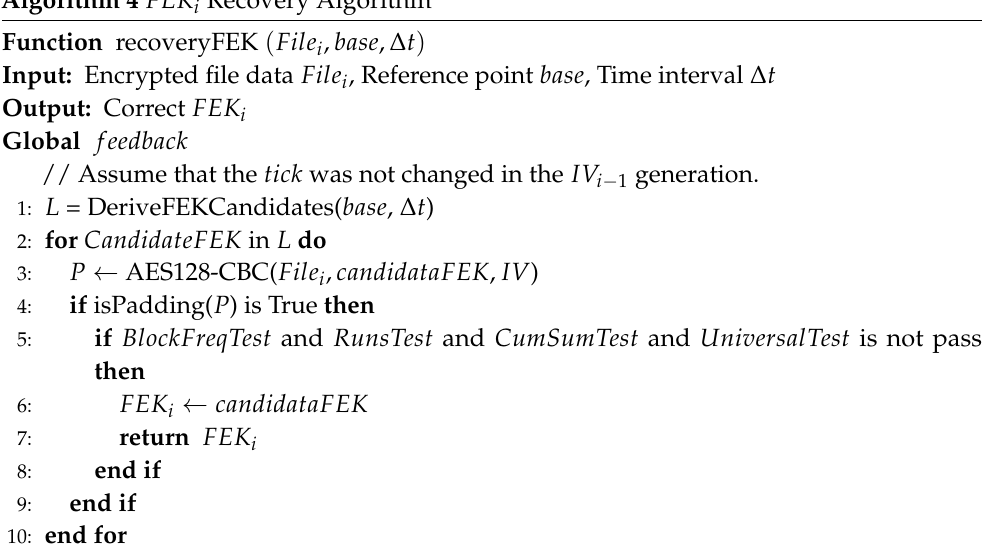
Algorithm 4 FEK i Recovery Algorithm Function recoveryFEK ( File i , base , ∆ t